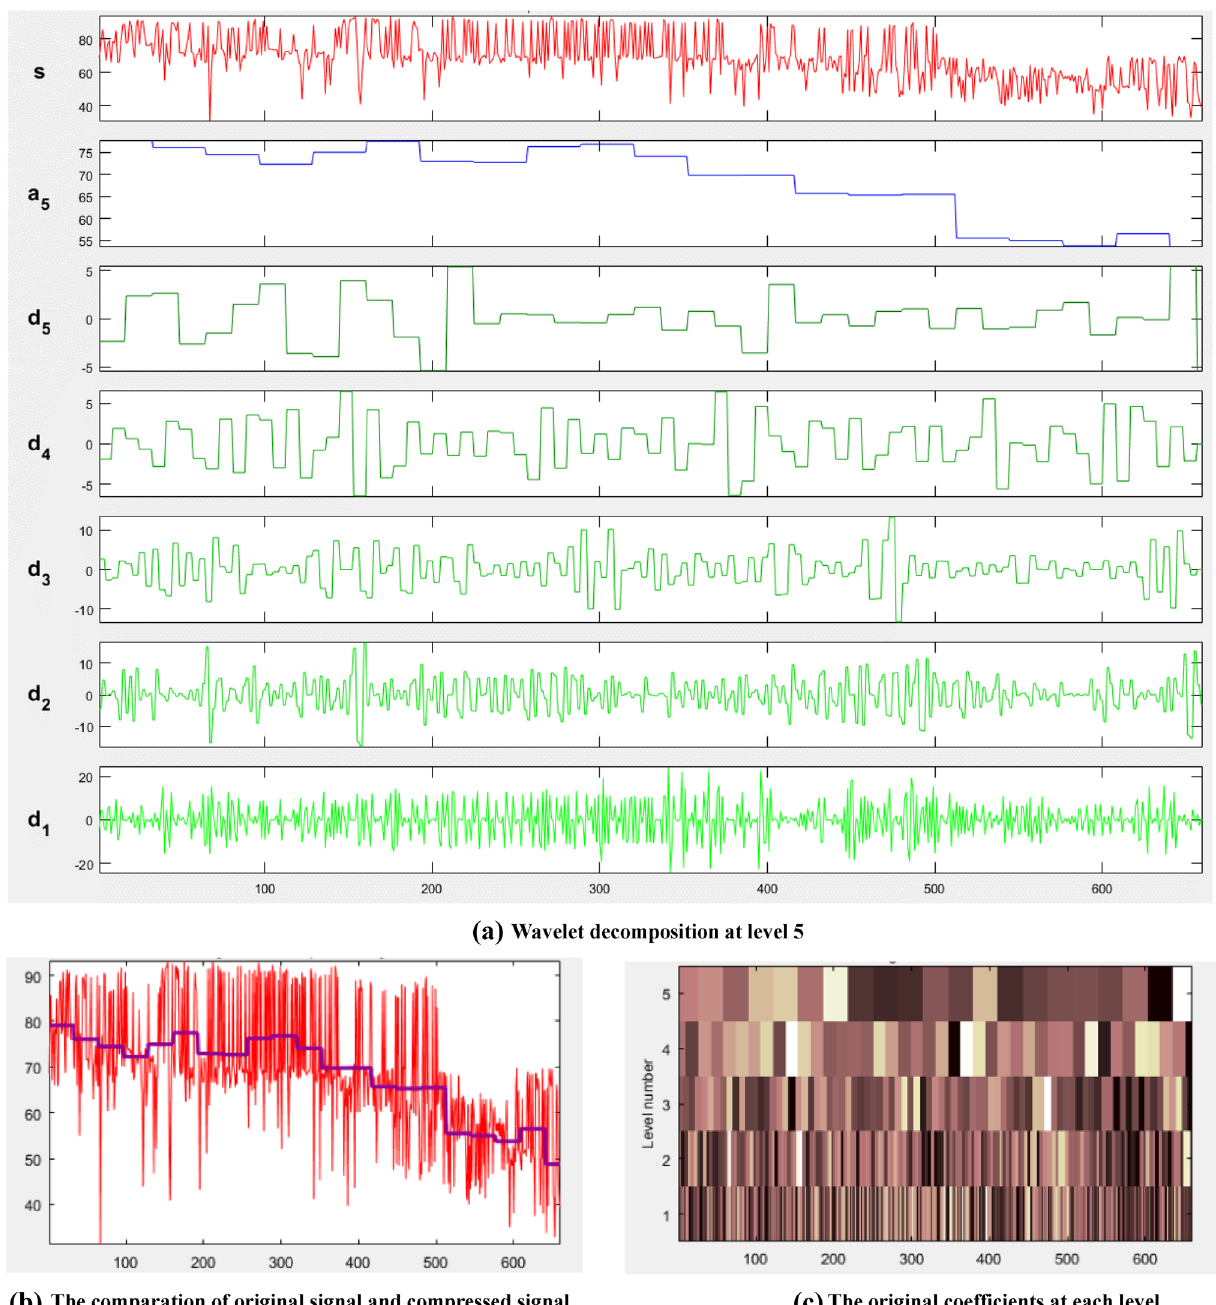
Fig. 4 Wavelet analysis results with PCA component 1 of mud logger dataset in sample well. a Wavelet decomposition at level 5, b the compari- son of original signal and compressed signal, c the original coefficients at each